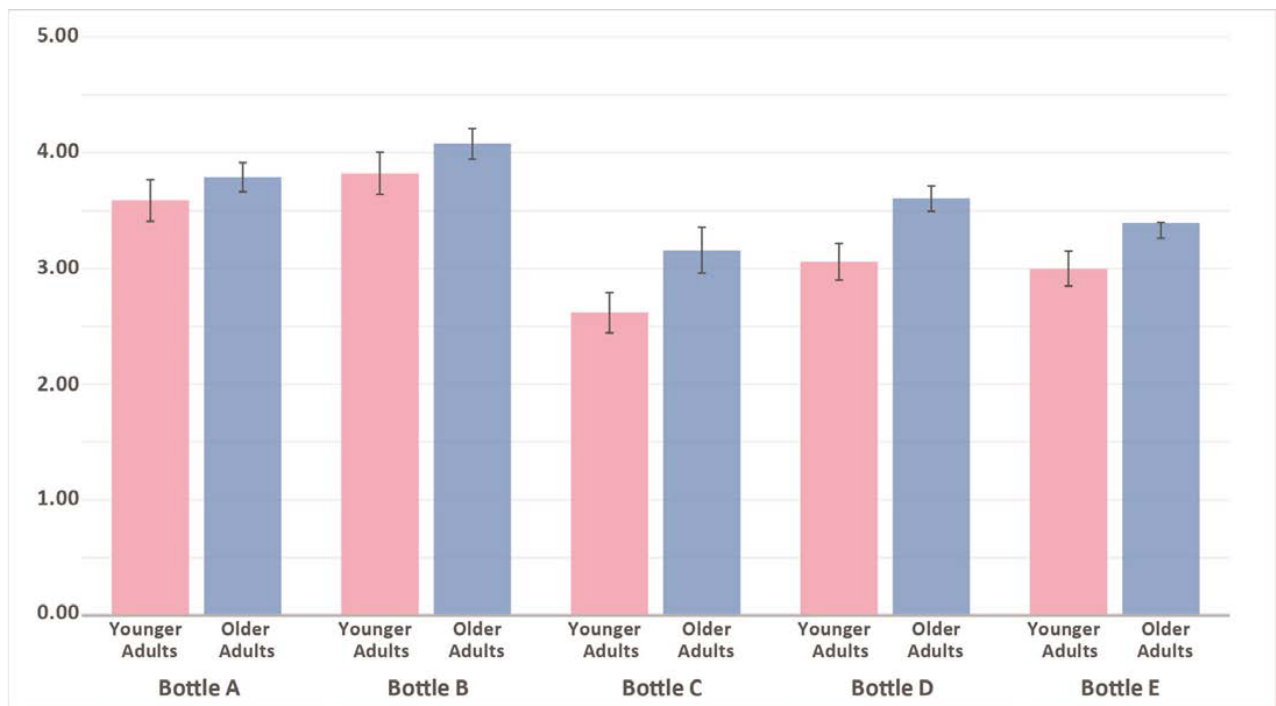
Figure 2. Comparison of the experience opening water bottles between age groups.